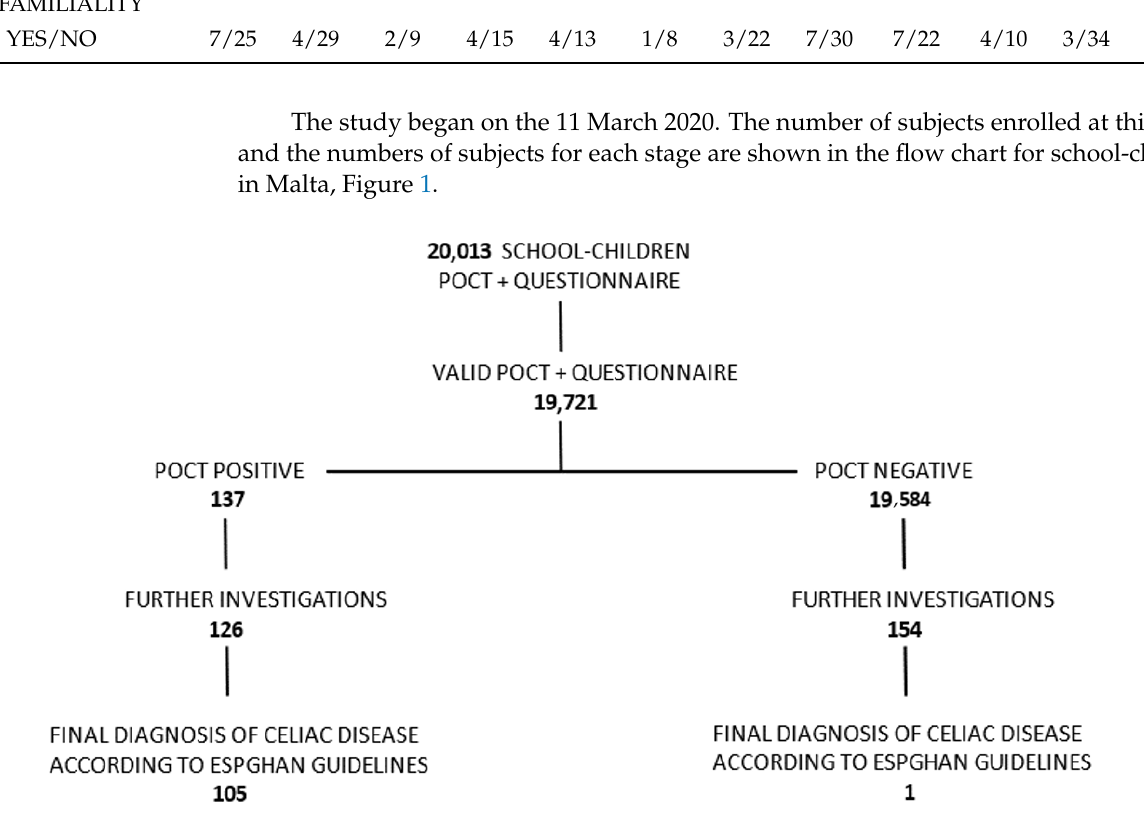
Figure 1. Diagram of study protocol in Malta, number of patients enrolled as of March 2022, and preliminary results.